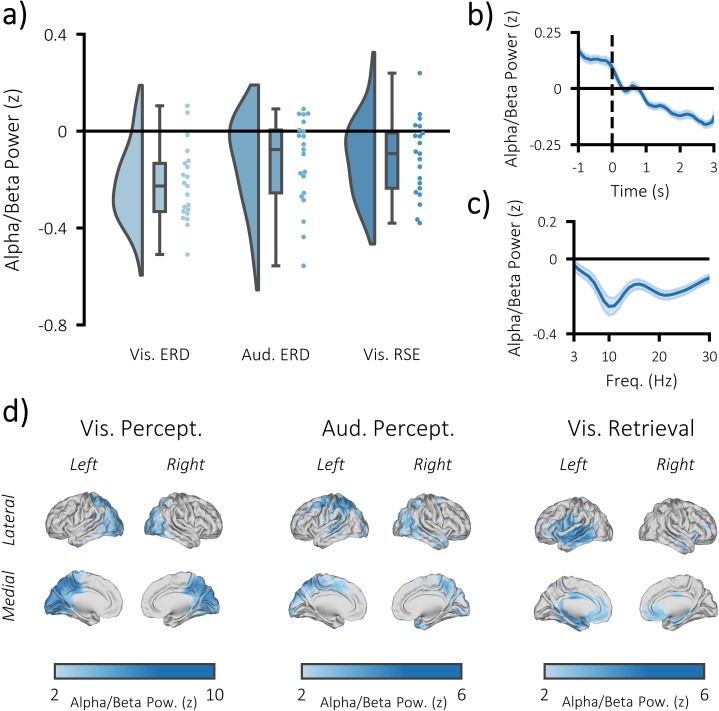
Task-induced decreases in post-stimulus alpha/beta power.(a) Raincloud plot displaying event-related decreases in power during visual perception (left) and auditory perception (middle), and memory-related decreases in power during visual retrieval (each dot represents a single subject). (b) time-series of alpha/beta (8–30 Hz) power change over time across all three tasks (see Figure 3—figure supplement 1 for each task individually). The dark line indicates the mean across participants; the shaded error bar represents standard error of the mean [N.B. as the electrodes were chosen because they belonged to the significant cluster, these figures are for descriptive purposes only and should not be used for statistical inference]. (c) frequency spectrum of post-stimulus power across all three tasks (500–1500 ms; referenced to −1000 to −375 ms pre-stimulus power). The dark line indicates the mean across participants; the shaded error bar represents standard error of the mean (see Figure 3—figure supplement 1 for each task individually). (d) brain maps of the event-related (left/middle) and memory-related (right) differences in alpha/beta power.